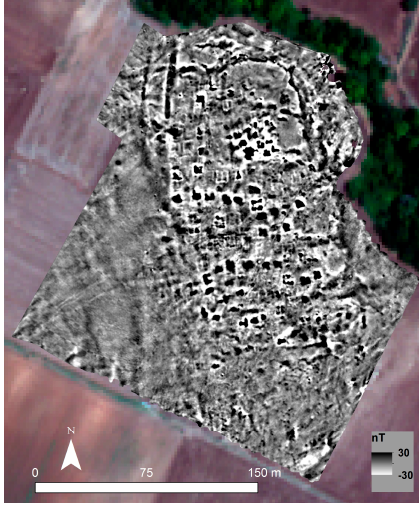
Figure 9. Geomagnetic data from Perdika 1. Palimpsest of two architectural groups are visible in the dataset. The settlement enclosure is the most visible in the north.